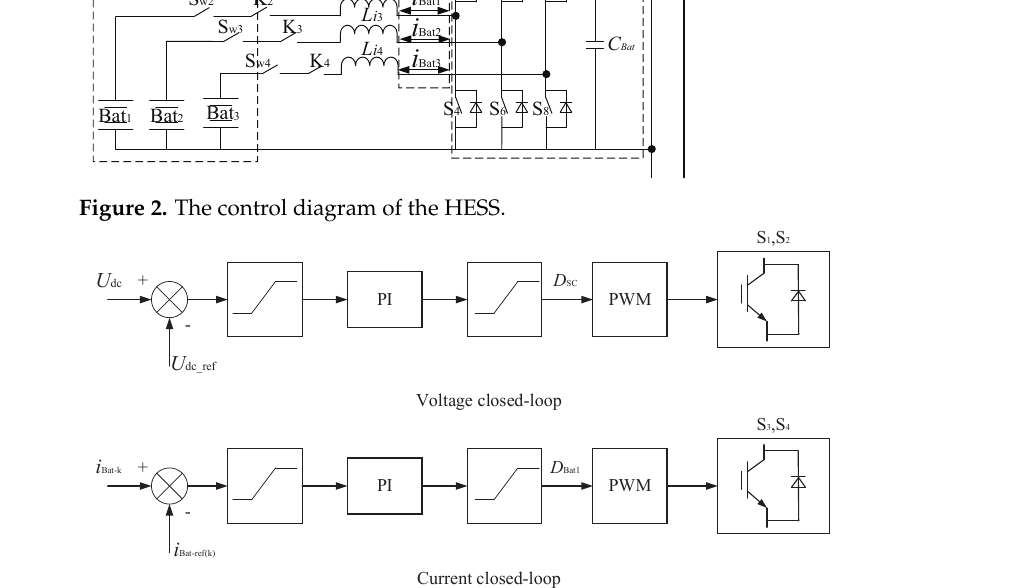
Figure 4. The AEO aims to optimize the charging/discharging of the battery module and adjust the SC module terminal voltage near the reference voltage. First, the filtering algorithm is used to obtain the P load 2 for the fluctuation load. Adaptive voltage control is introduced, so the transmission power of the battery pack can be adjusted in real-time according to the SC module terminal voltage, and the compensation power P com can be obtained. Then, the actual load P load 1 , the fluctuation load P load 2 , and the compensation power P com are added to calculate the transmission power P Bat of the battery pack.